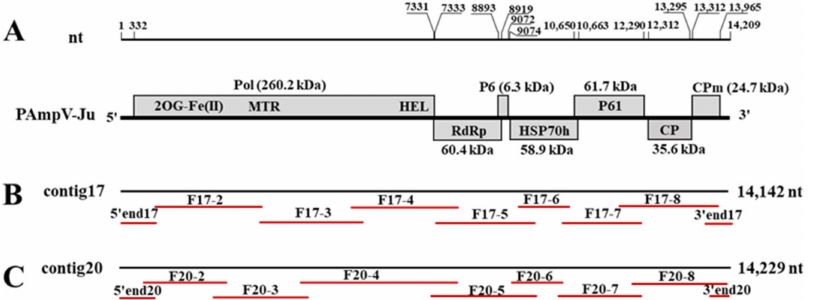
Figure 1. Genome organization of persimmon ampelovirus jujube isolate (PAmpV-ju) showing relative positions of the open reading frames (ORFs) and their expression products ( A ), and the positions fragments amplified by RT-PCR on contig17 and contig20 ( B , C ). The red lines under two contigs represent the fragments amplified using primer sets specific for contig17 and